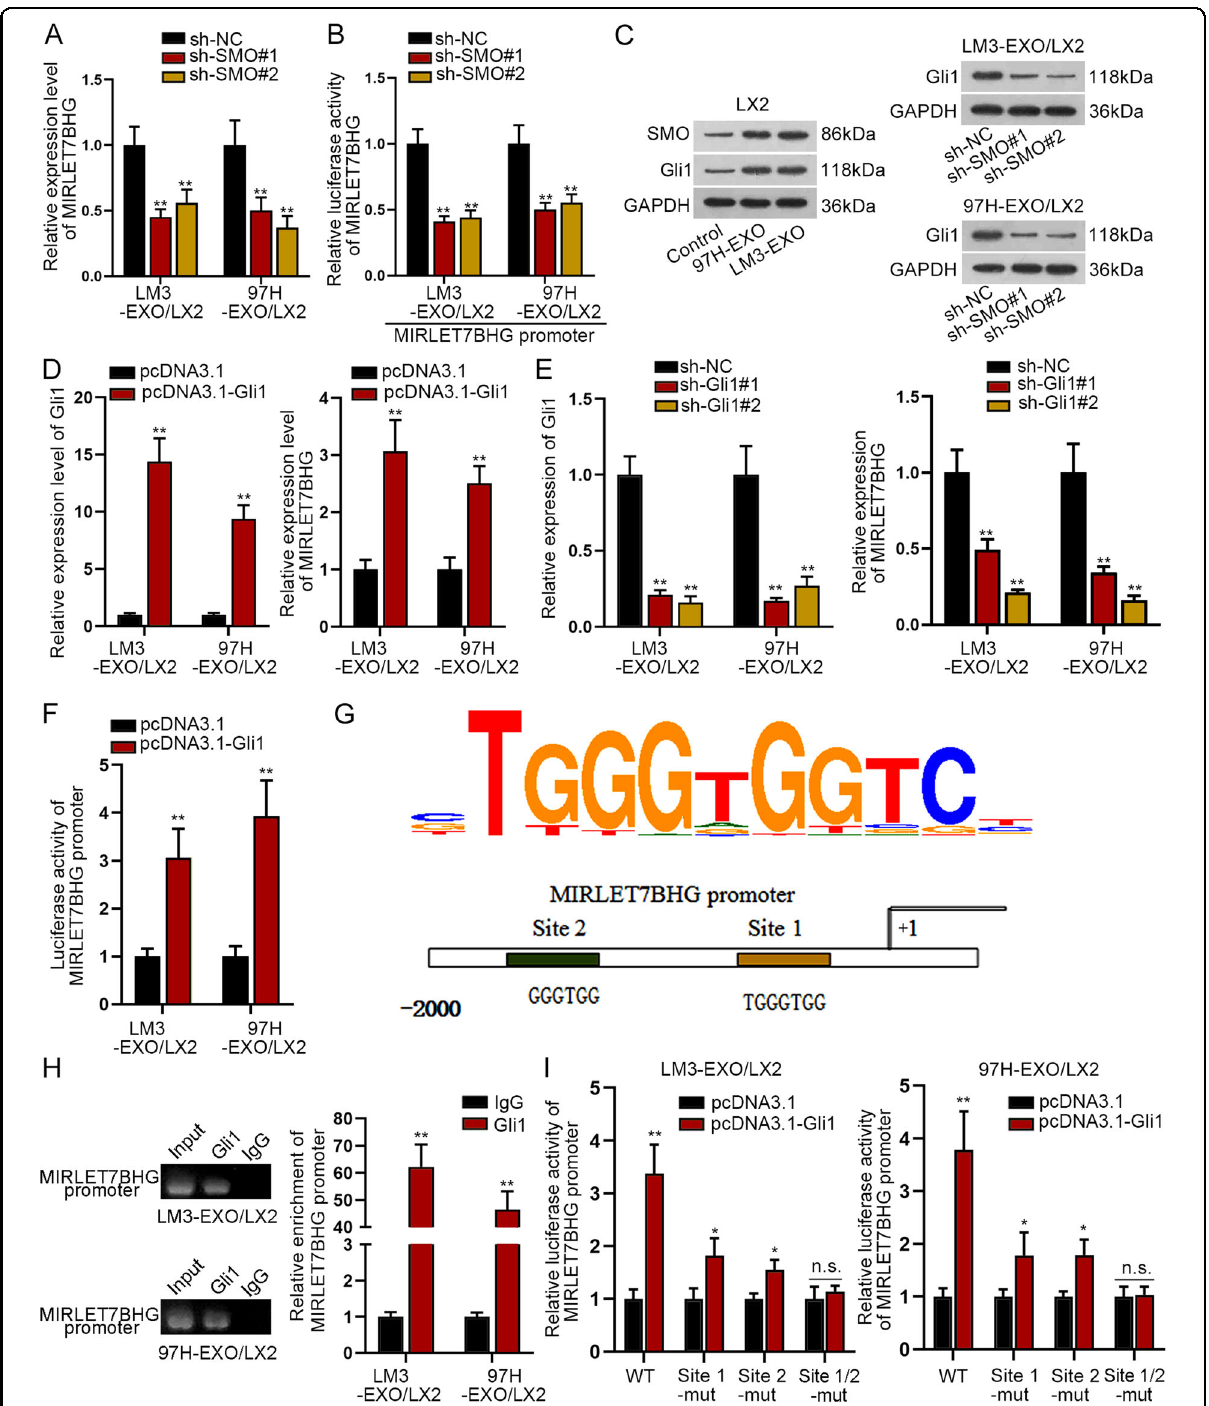
Fig. 6 Gli1 transcriptionally activated MIRLET7BHG. A qRT-PCR revealed the in fl uence of silenced SMO on MIRLET7BHG expression. B Luciferase reporter assay disclosed the luciferase activity of MIRLET7BHG promoter when SMO was subjected to downregulation. C Western blot tested hedgehog pathway-associated proteins (SMO and Gli1) in indicated groups. D qRT-PCR veri fi ed the overexpression ef fi ciency of Gli1 and the in fl uence of upregulated Gli1 on MIRLET7BHG expression. E qRT-PCR tested the knockdown ef fi ciency of Gli1 and the in fl uence of downregulated Gli1 on MIRLET7BHG expression. F Luciferase reporter assay analyzed the luciferase activity of MIRLET7BHG promoter in activated HSCs with or without the upregulation of Gli1. G DNA motif of Gli1 and two binding sites of Gli1 on MIRLET7BHG promoter. H ChIP assay revealed the enrichment of MIRLET7BHG promoter in anti-Gli1 group relative to control anti-IgG group. I Luciferase reporter assay determined the impact of Gli1 overexpression on the luciferase activity of reporters with indicated MIRLET7BHG promoter (wild-type, site 1-mutated type, site two-mutated type, or site 1/2-mutated type). * P <0.05, ** P <0.01, “ n.s ” represents no signi fi